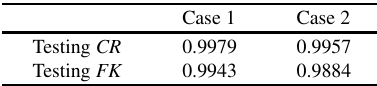
Table 1 Classification results for normal and fault states